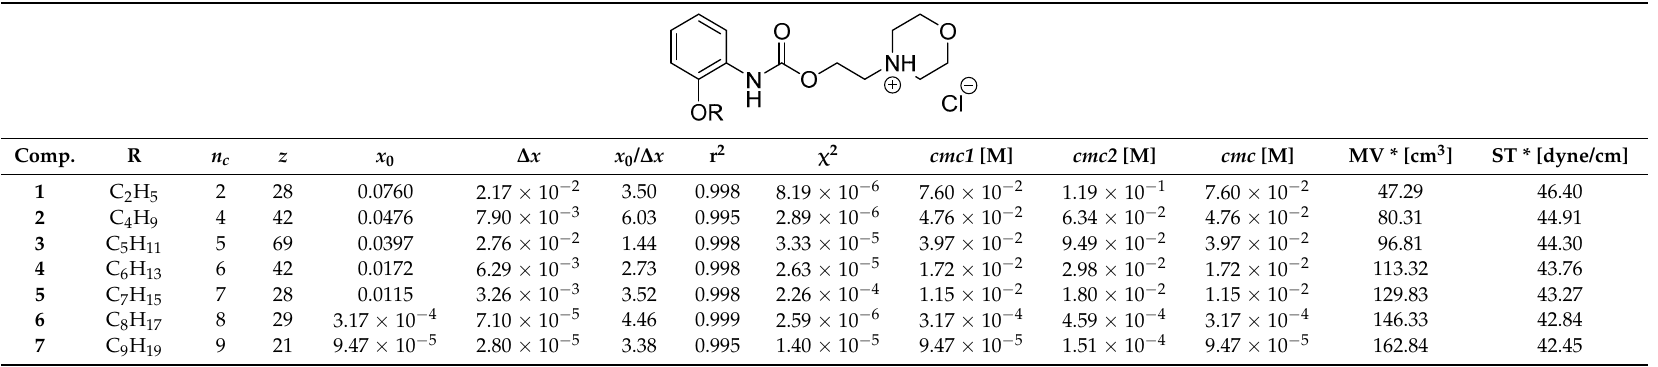
Molecules 2018 , 23 , x FOR PEER REVIEW Table 1. Structures of investigated 4-(2-{[(2-alkoxyphenyl)carbamoyl]oxy}ethyl)morpholin-4-ium chloride 1 – 7 , parameters of fitting functions with determined critical micellar concentration ( cmc ) values at 25 °C, and predicted values of molar volume (MV [cm 3 ]) of substituent R and surface tension (ST [dyne/cm]).